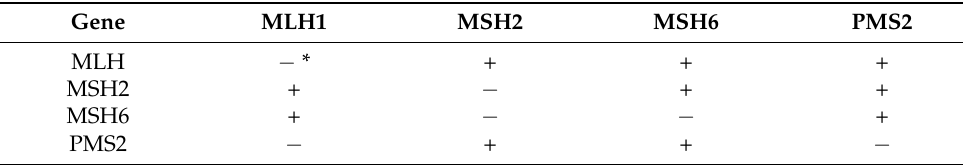
Table 4. Protein expression in MMR-gene mutations. MLH1 MSH2 MSH6